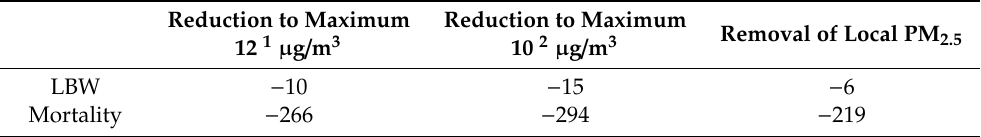
Table 4. Change in the number of outcomes (LBW instances or deaths) in hypothetical scenarios involving the reduction of PM 2.5 concentrations to various